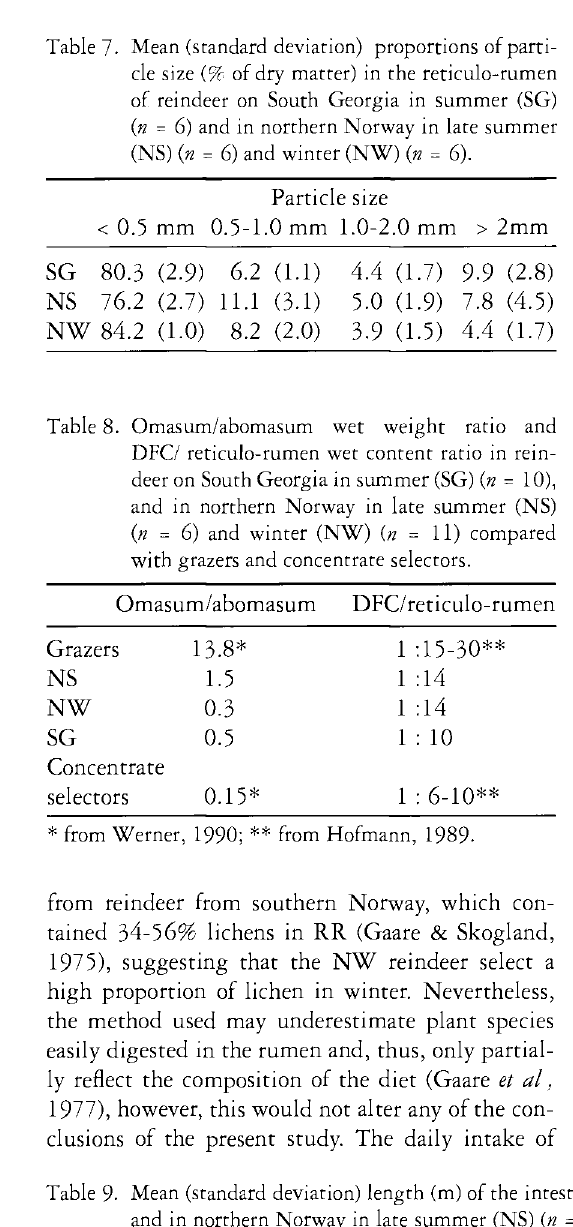
Table 9. Mean (standard deviation) length (m) of the intestines in reindeer on South Georgia in summer (SG) (n = 10), and in northern Norway in late summer (NS) (n = 6) and winter (NW) (n = 11) compared with ruminants of the grazer and concentrate selector